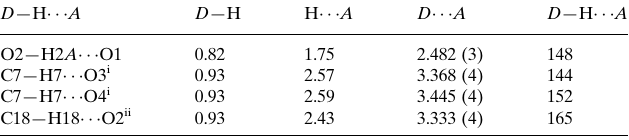
Hydrogen-bond geometry (A˚ , (cid:2)